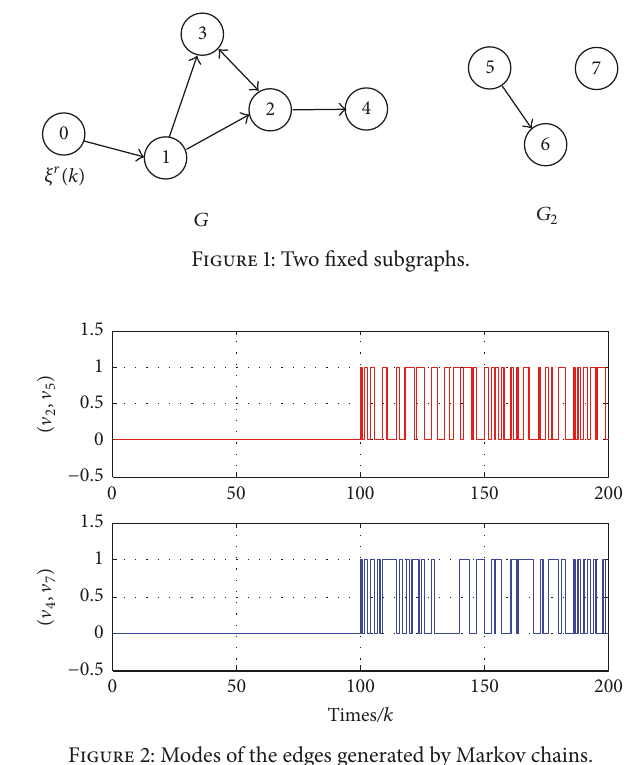
Figure 2: Modes of the edges generated by Markov